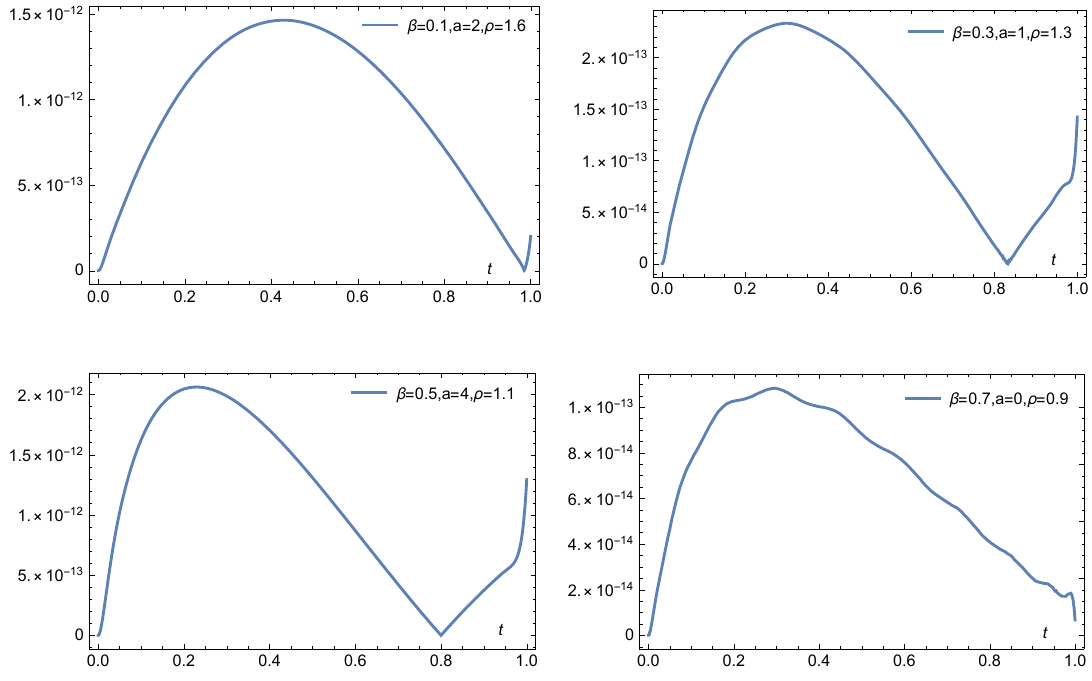
Figure 5. The absolute errors of Example